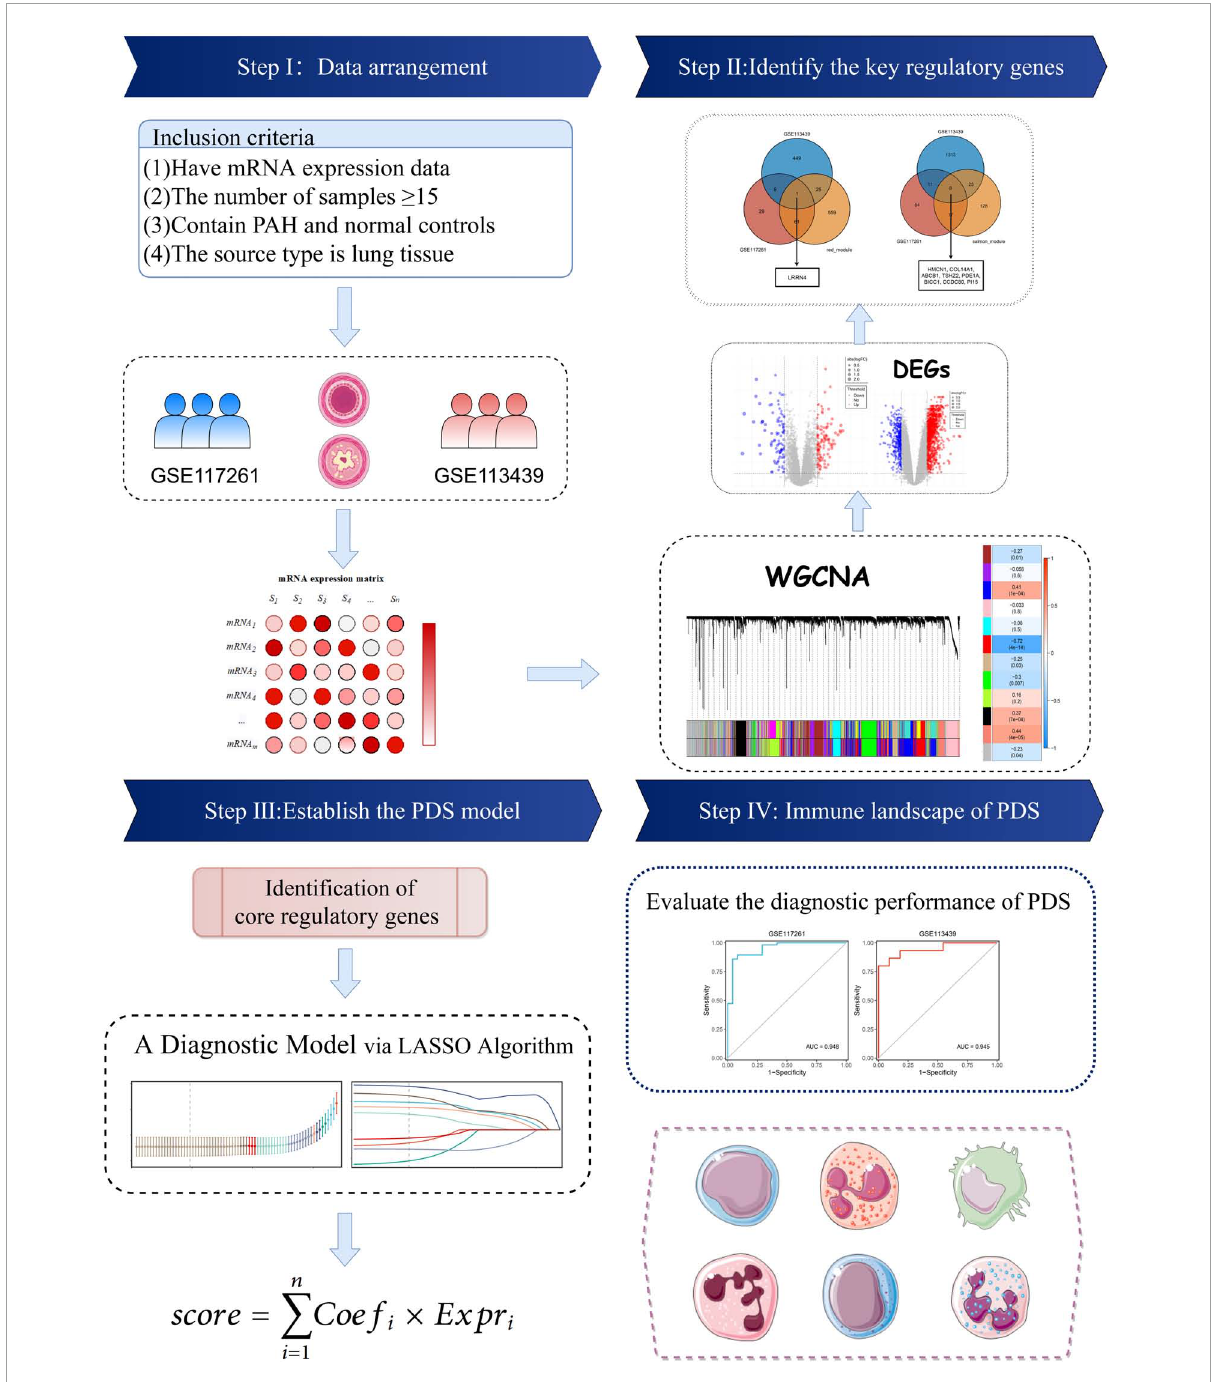
FIGURE1 Flowchart of this study.